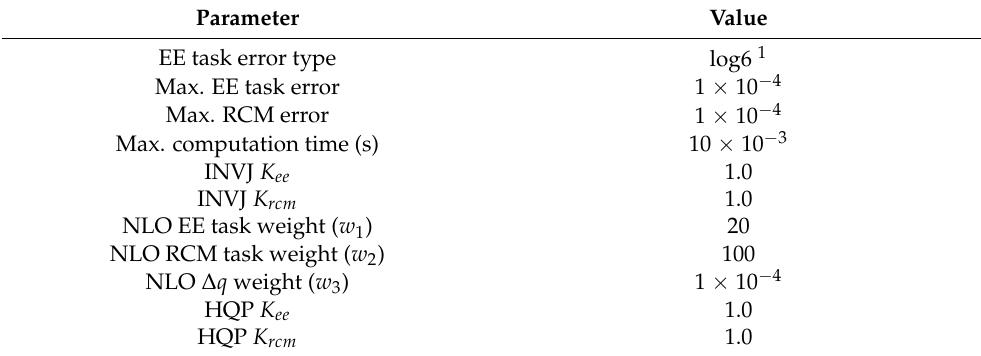
Table 3. Parameters used for the constrained inverse kinematics